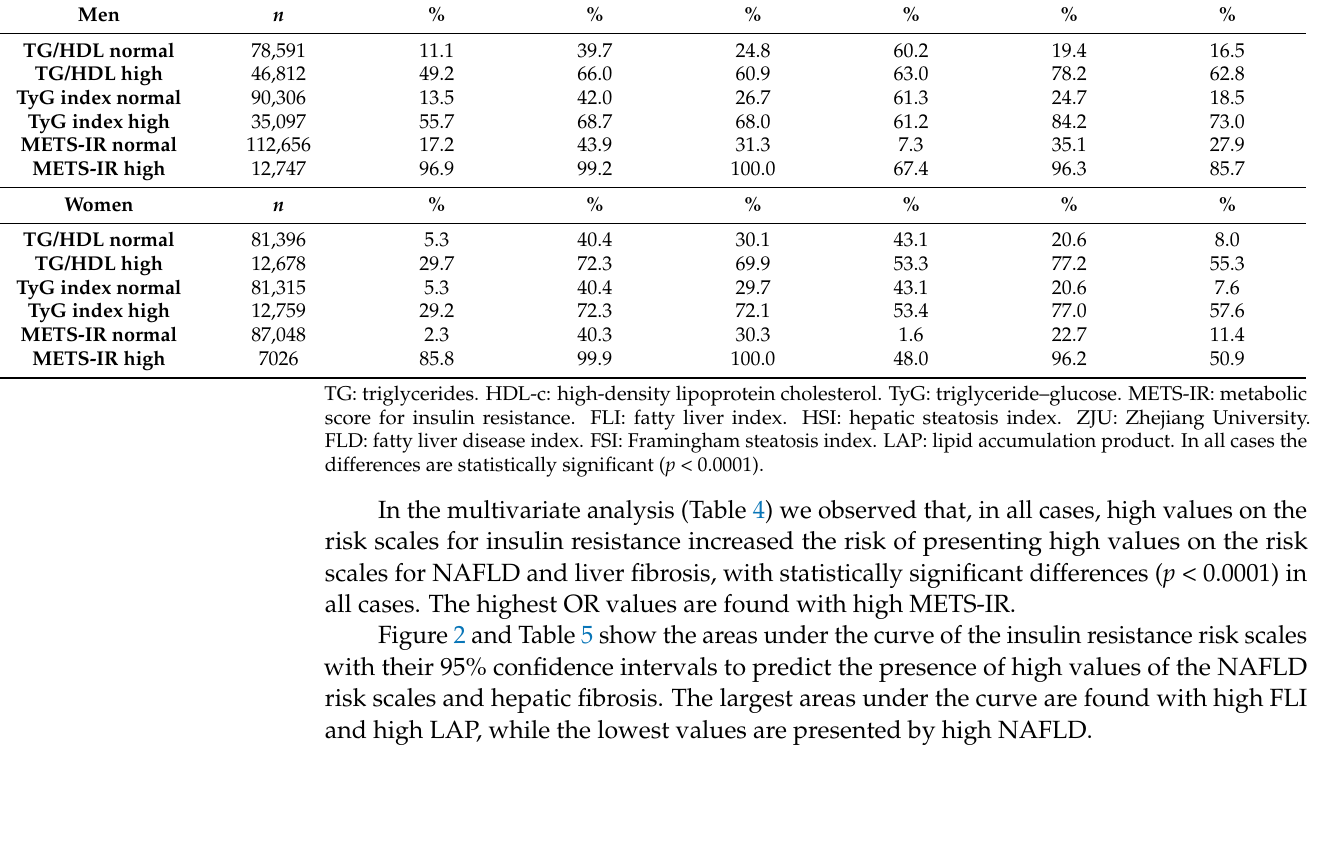
Table 3 shows that the prevalence of high-risk values on the NAFLD and liver fibrosis scales is higher in people who present high values on the insulin resistance risk scales in both sexes. In all cases the differences are statistically significant ( p < 0.001). Table 3. Prevalence of high values of the different NAFLD and liver fibrosis risk scales according to values of insulin resistance risk scales. FLI High HSI High ZJU High LAP High BARD